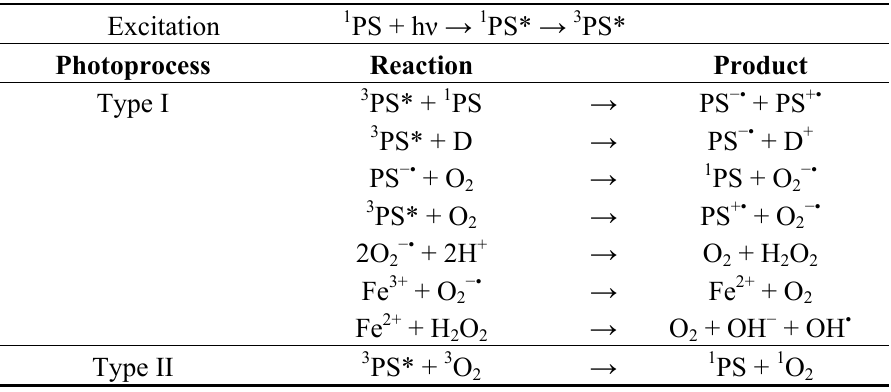
Table 1. Reactions occurring during photodynamic action [9].